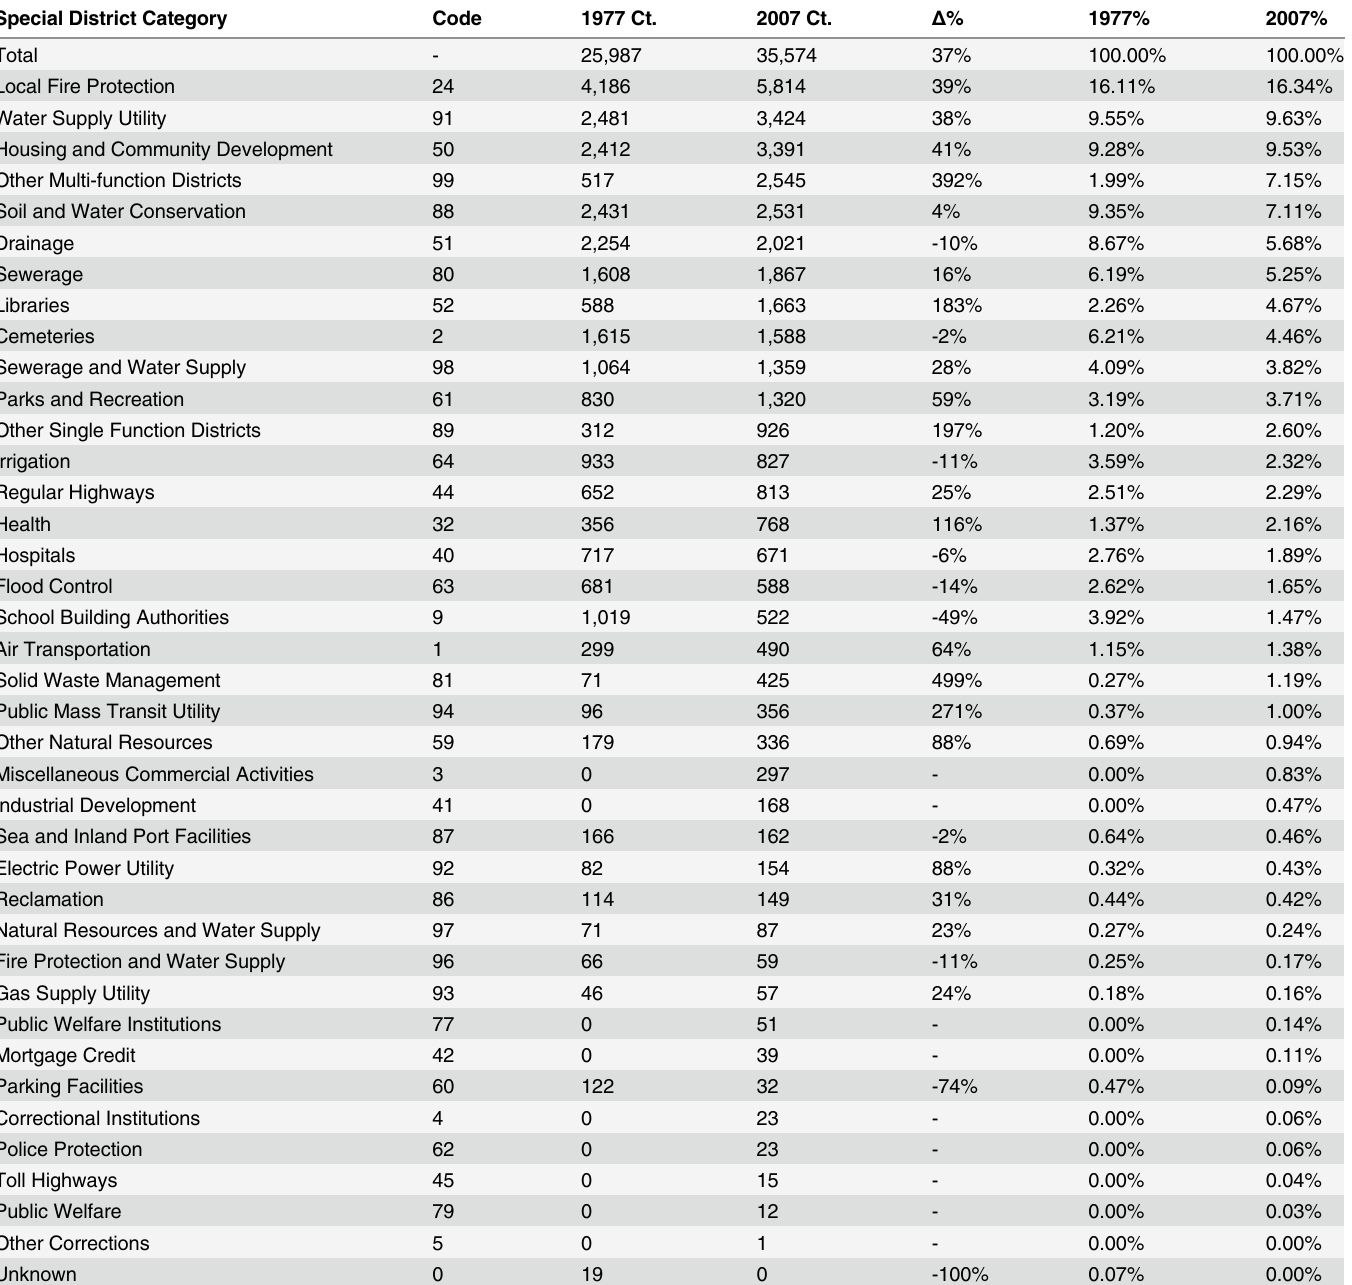
Table 12. Special District